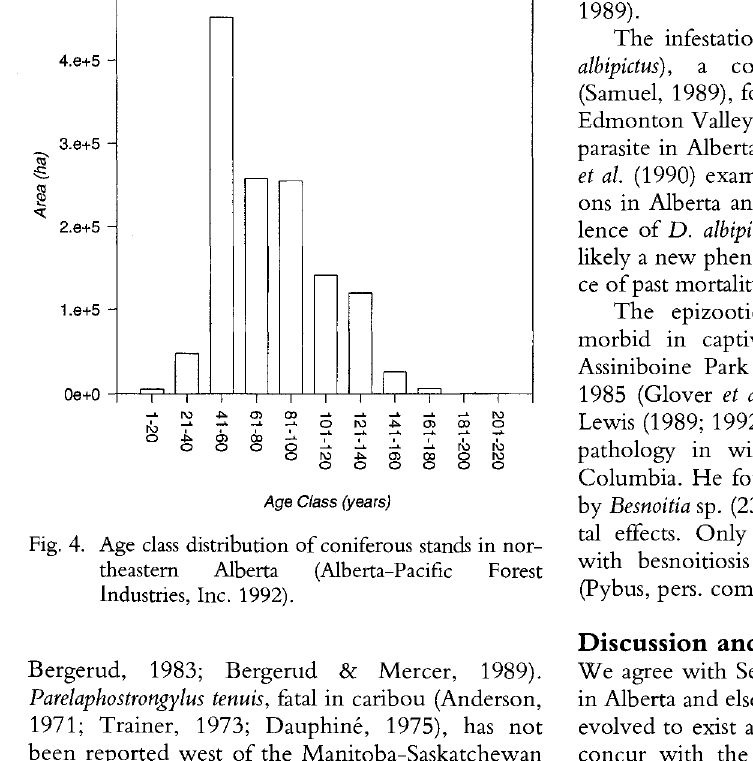
Fig. 4. Age class distribution of coniferous stands in nor theastern Alberta (Alberta-Pacific Forest Industries, Inc.